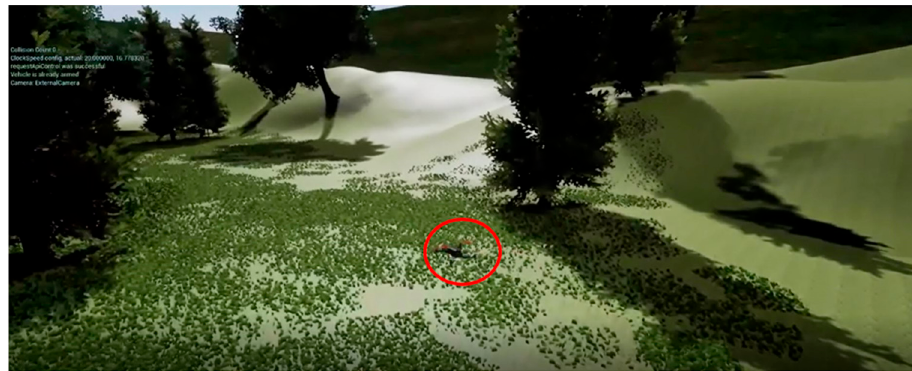
Figure 37. A scene full of trees and undulating terrain.